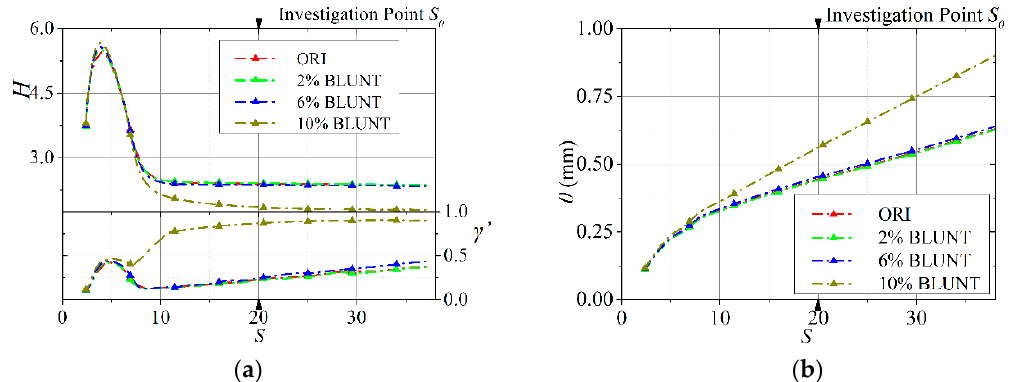
Figure 7. The BLUNT of Ellip.LE at Tu = 5%: ( a ) the boundary layer shape factor and normal average turbulence intermittency; ( b ) the momentum thickness along aerofoils.